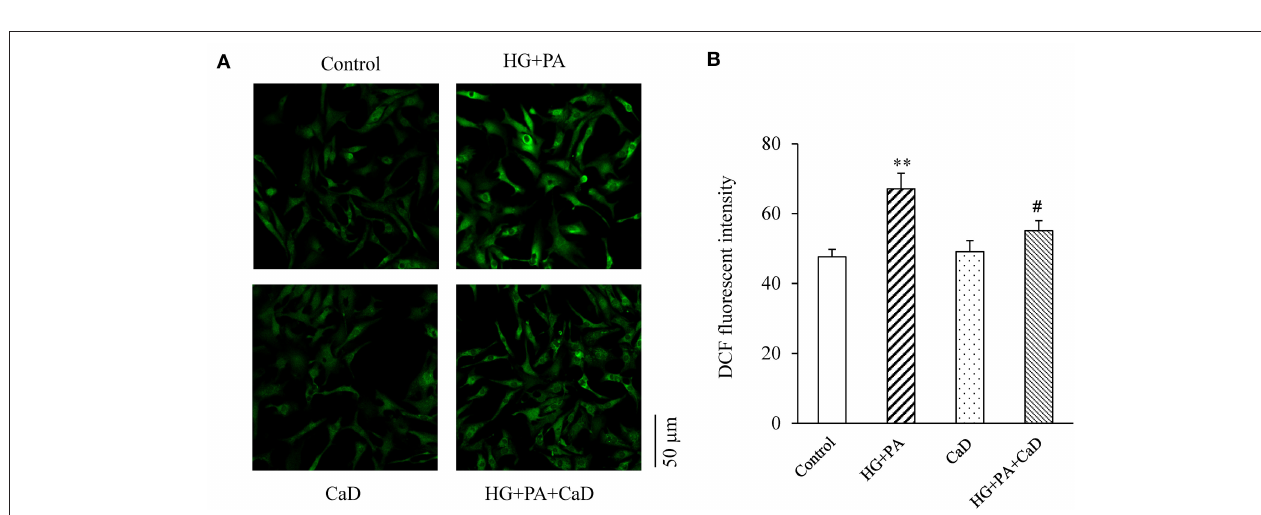
FIGURE 4 | HG + PA increases the level of ROS in neonatal cardiomyocytes. Representative fluorescence images (A) and quantification (B) of ROS production. ** p < 0.01 vs. control; # p < 0.05 vs. HG +